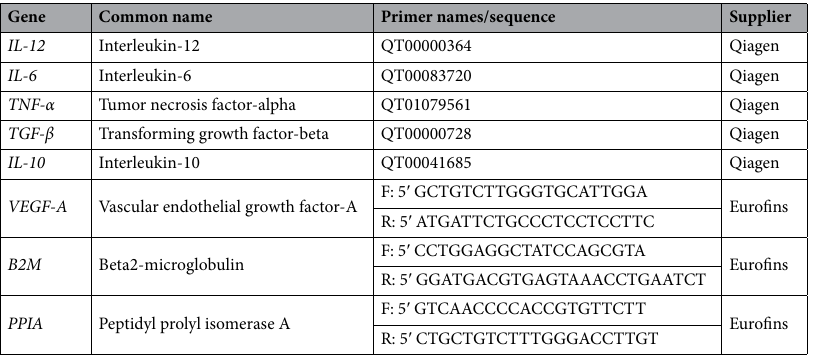
Table 1. Targets, names, and sequences of the primers used for the real-time PCR analysis of mRNA expression in human monocytes/macrophages. F: forward, R: